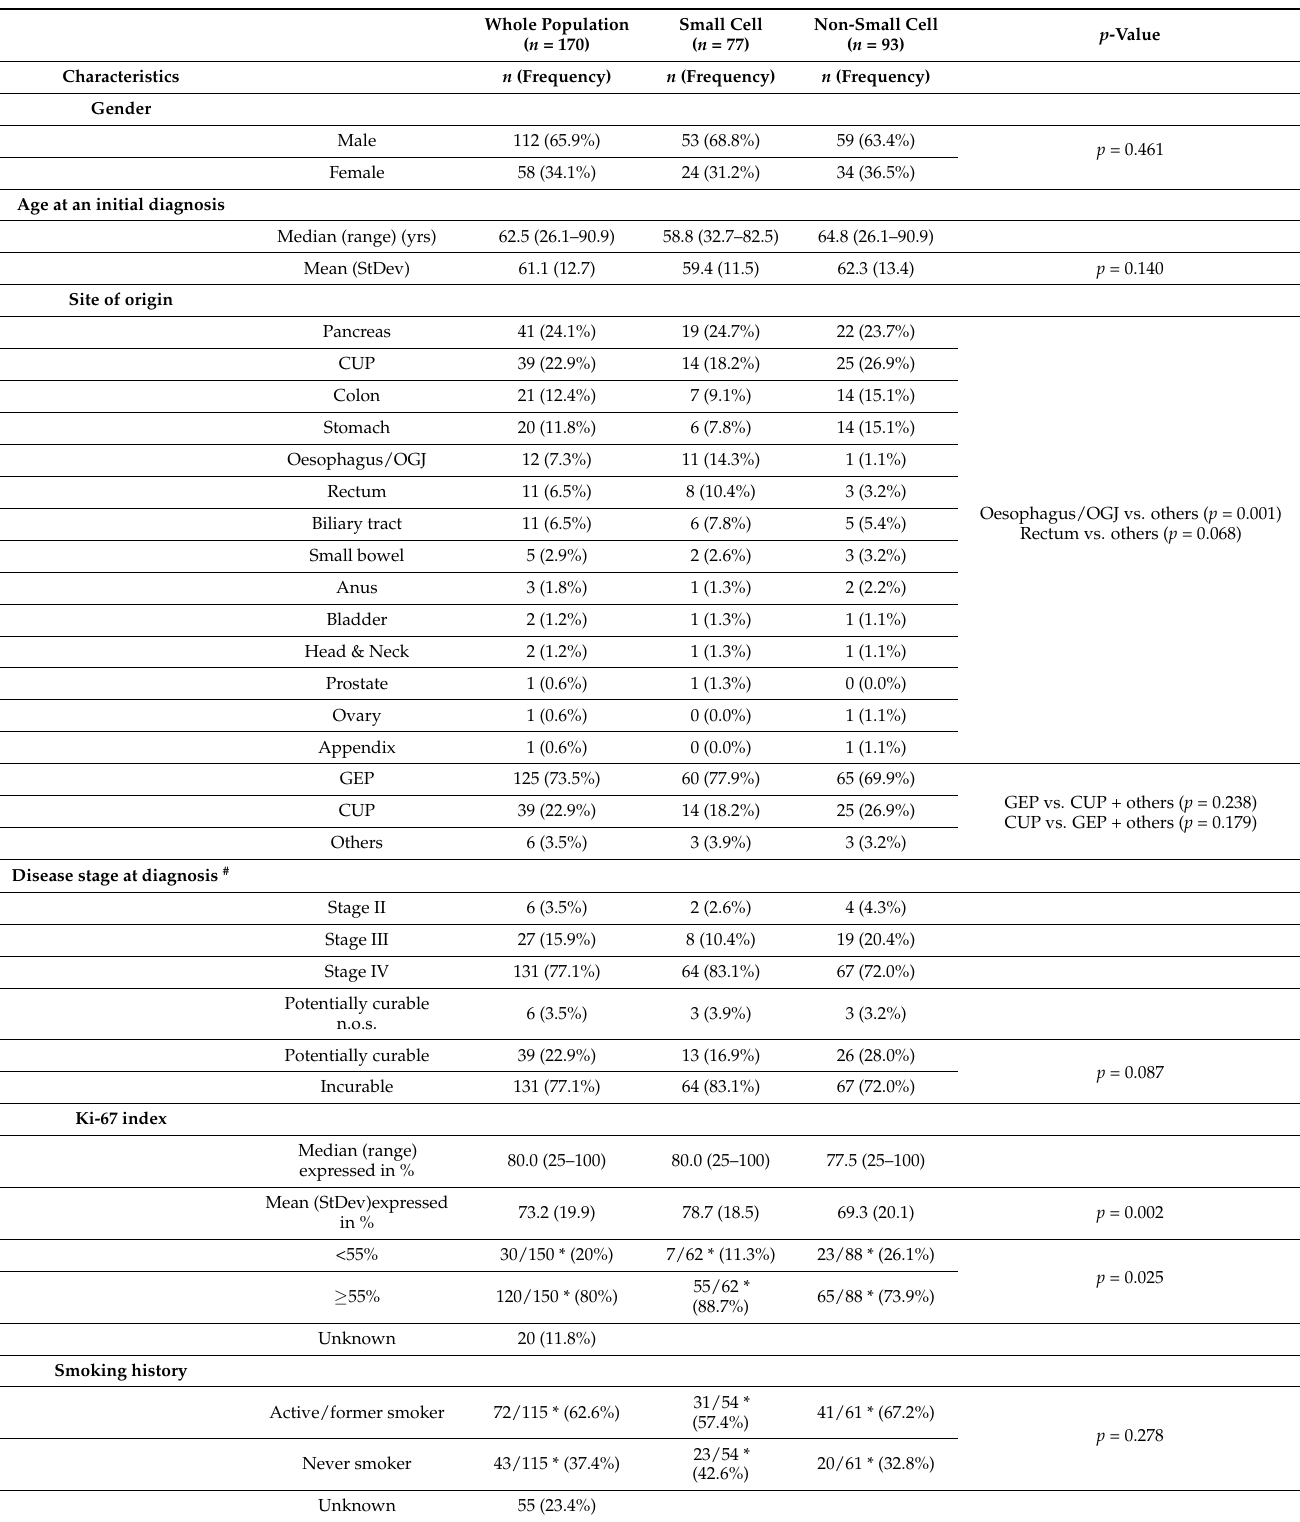
Table 1. Clinico-pathological characteristics of patients with extra-pulmonary neuroendocrine carcinomas included in this study.